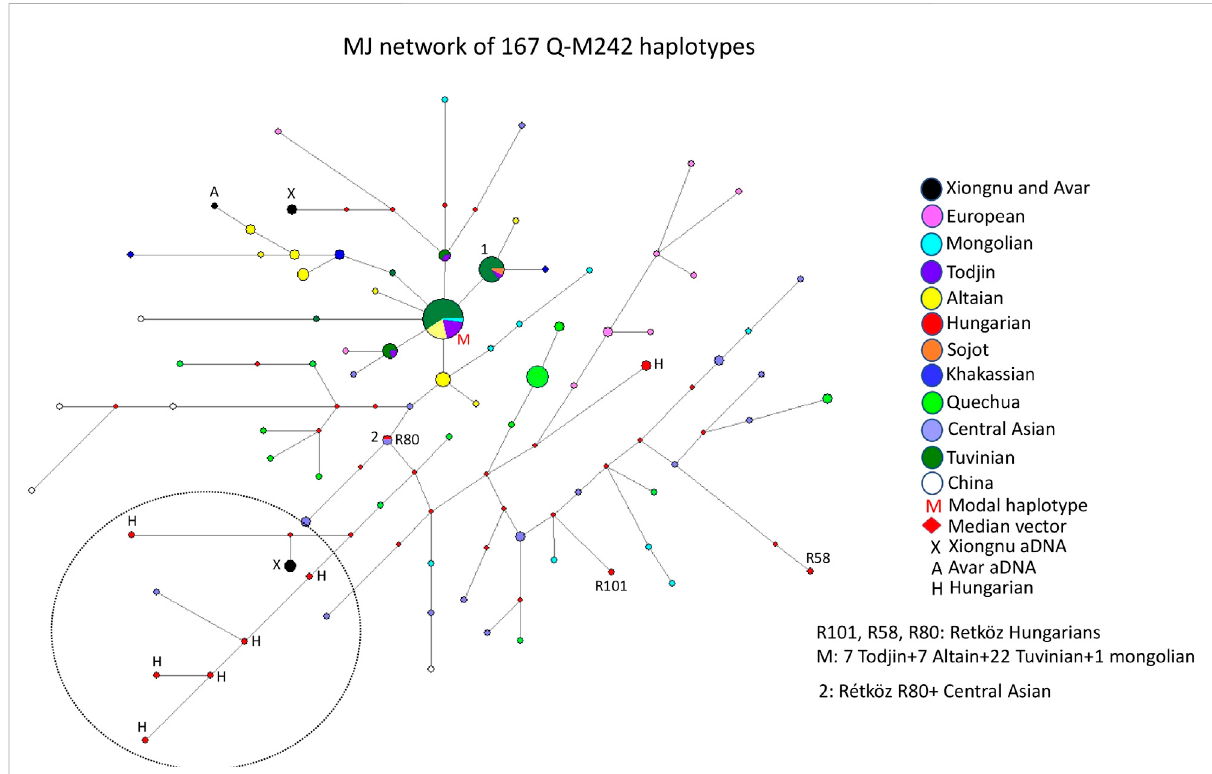
FIGURE 5 TheMedian-JoiningNetworks(MJ)of167Q-M242haplotypes.Thecirclesizesareproportionaltothehaplotypefrequencies.Thesmallestarea is equivalent to one